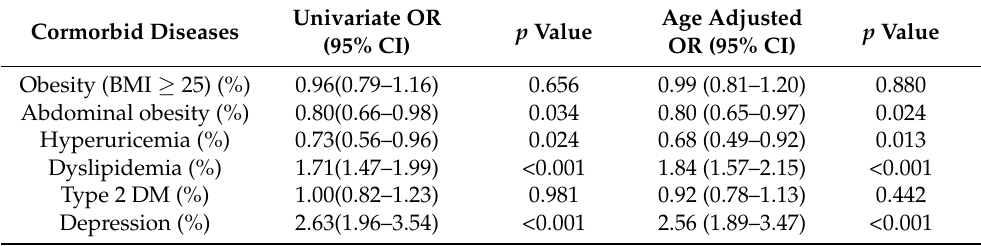
Table 3. Logistic regression analysis of comorbid diseases with osteoporosis adjusted by age in total subjects.